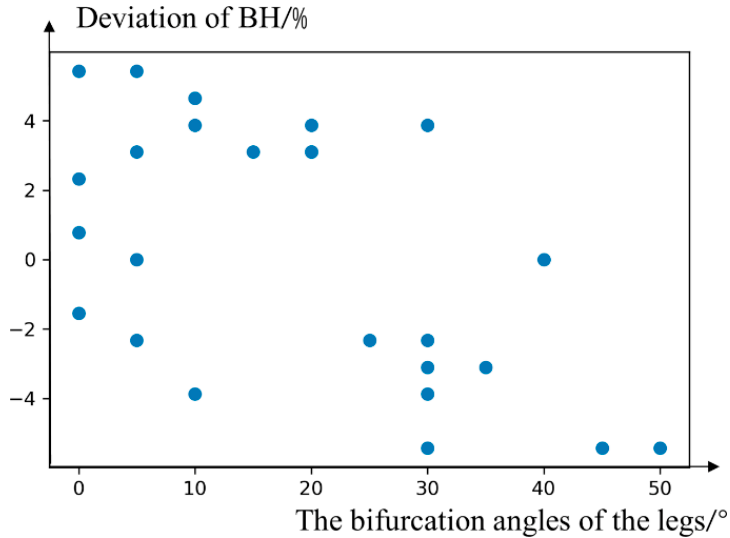
Figure 19. Relationship between the bifurcation angles and wither height errors. As Figure 19 shows, a larger bifurcation angle was generated when the calculated wither height was significantly smaller than the real value, which indicated that the leg crossover can lead to reduction in wither height (Figure 20).